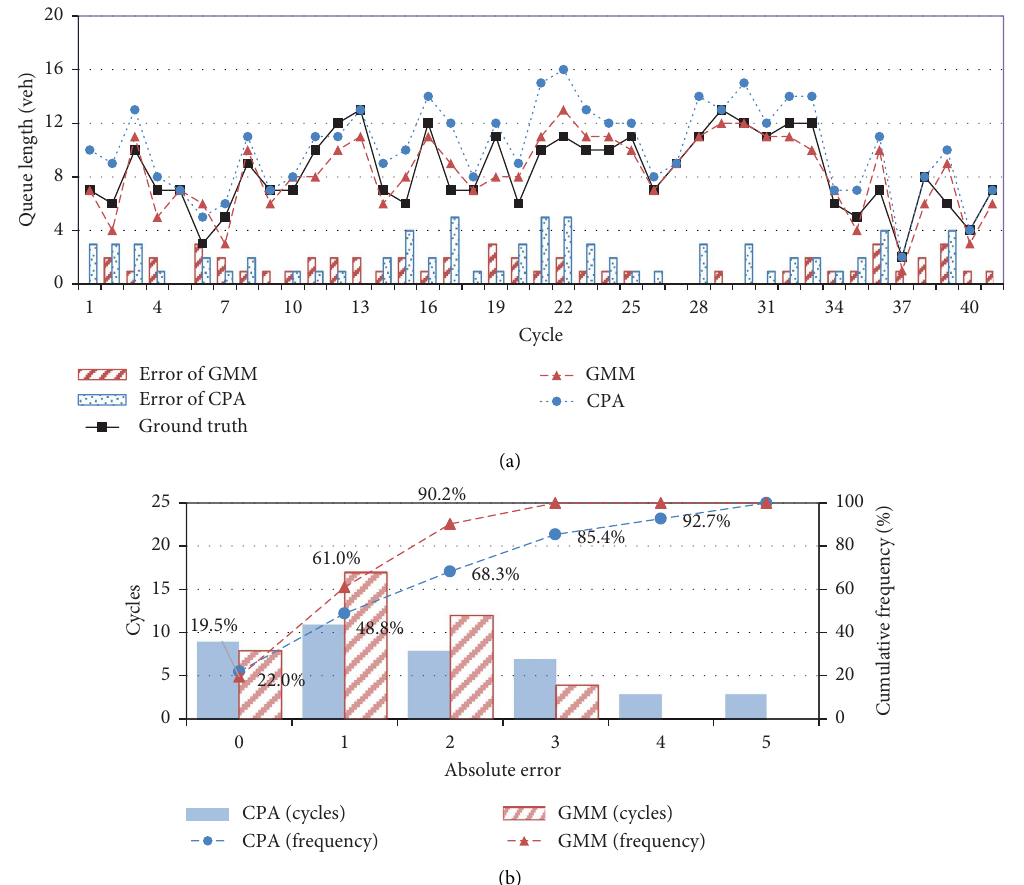
Figure 6: Lane-based queue length estimation results for cycles. (a) Cycle-based estimates. (b) Error statistics.